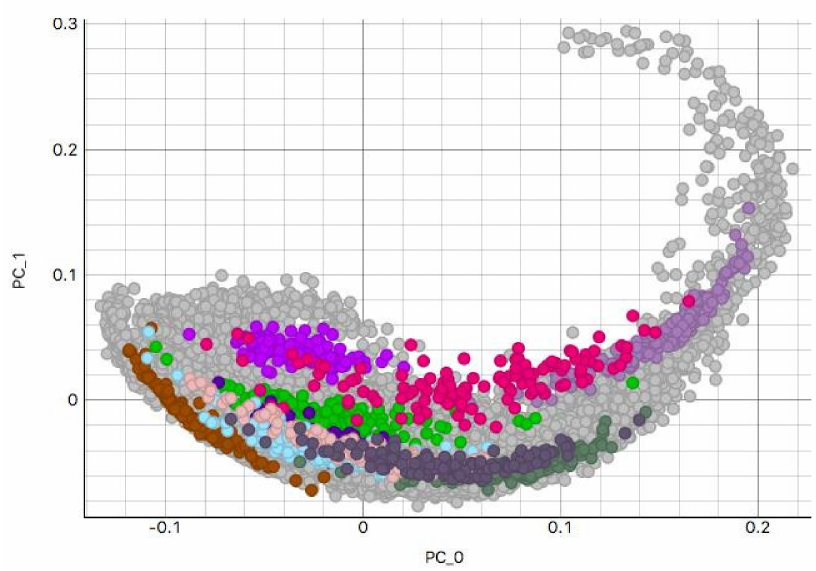
Figure 8. Skin tissue tiles shown along the first two principal components. Colors represent random laboratory tiles. Due to the high number, only a small number of tiles can be shown without